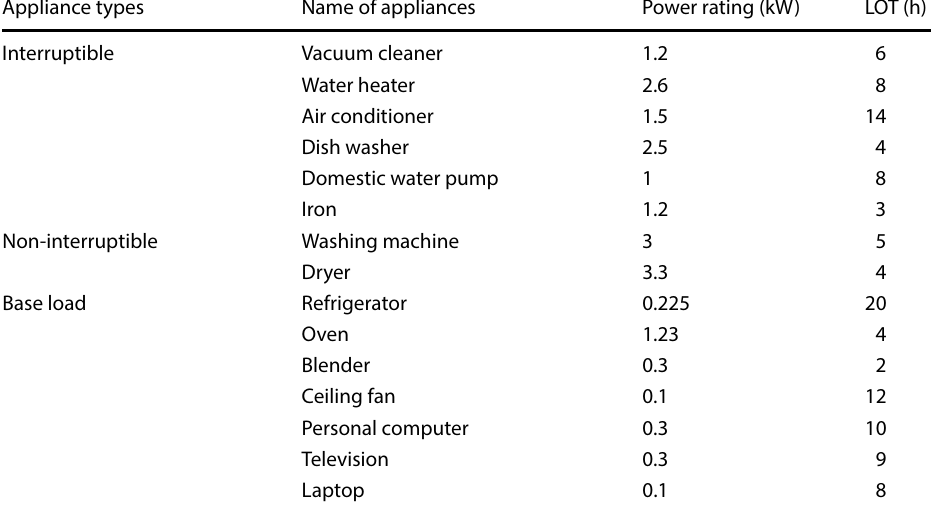
Table 1 Appliances specifications